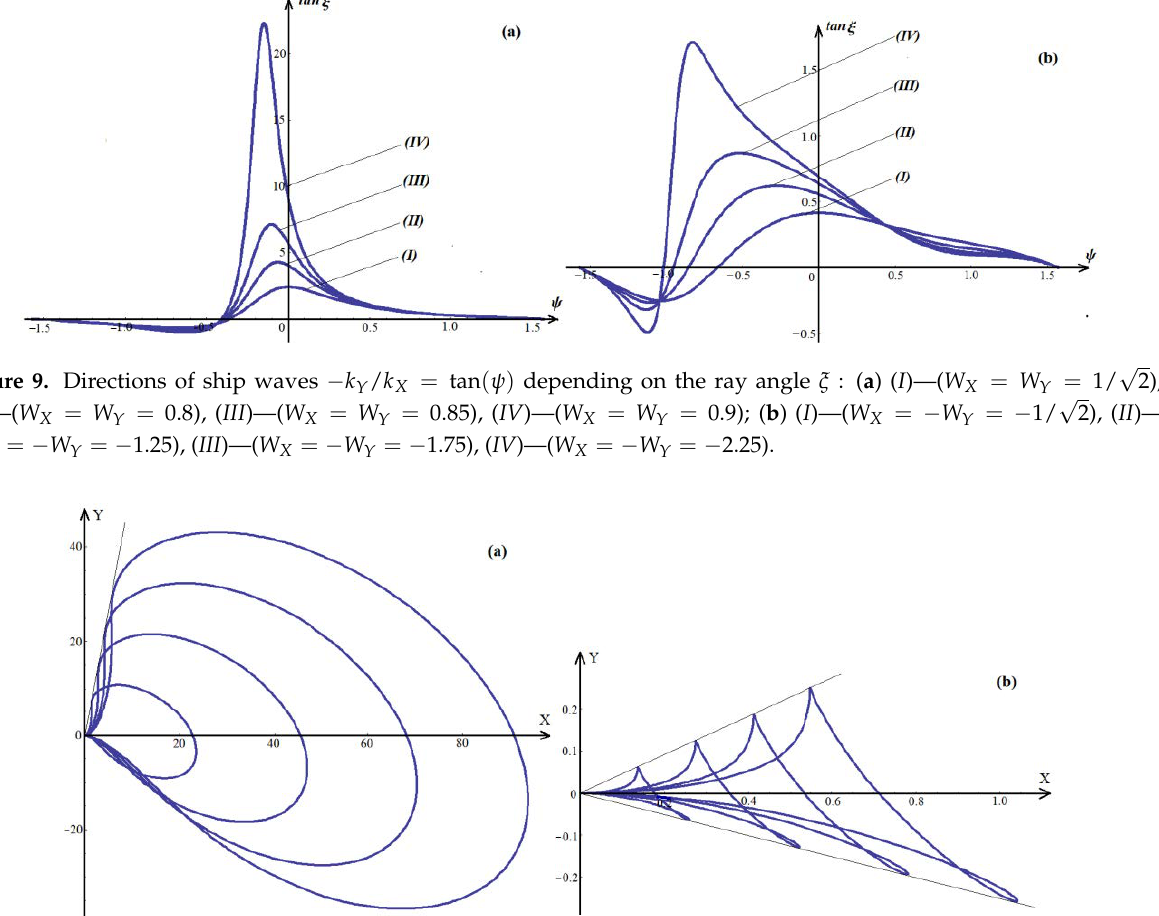
= W = 0.82); ( b ) opposite X Y